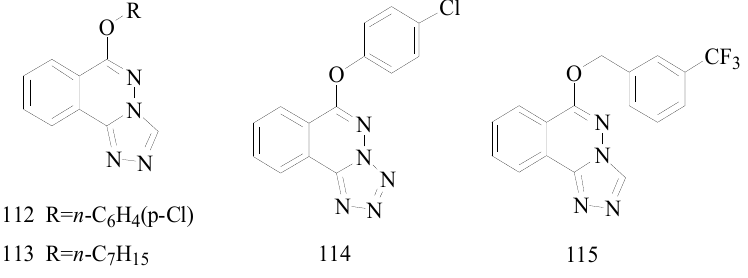
Figure 8. Structures of compounds 112 – 115 .